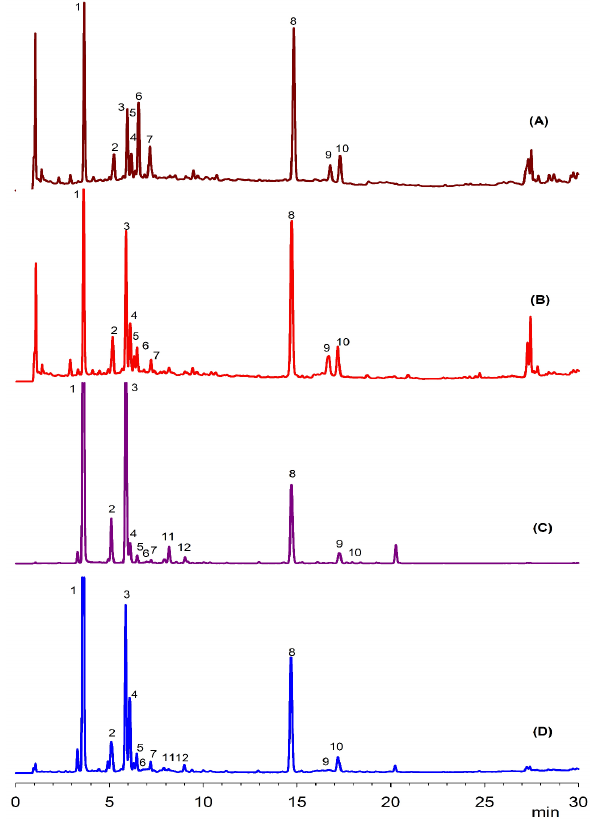
Figure 1. Representative HPLC-DAD chromatograms of the apricot leaves during maturation at 320 nm. ( A ) 15 days; ( B ) 30 days; ( C ) 45 days; and ( D ) 60 days. The identification of the peaks are given in Table